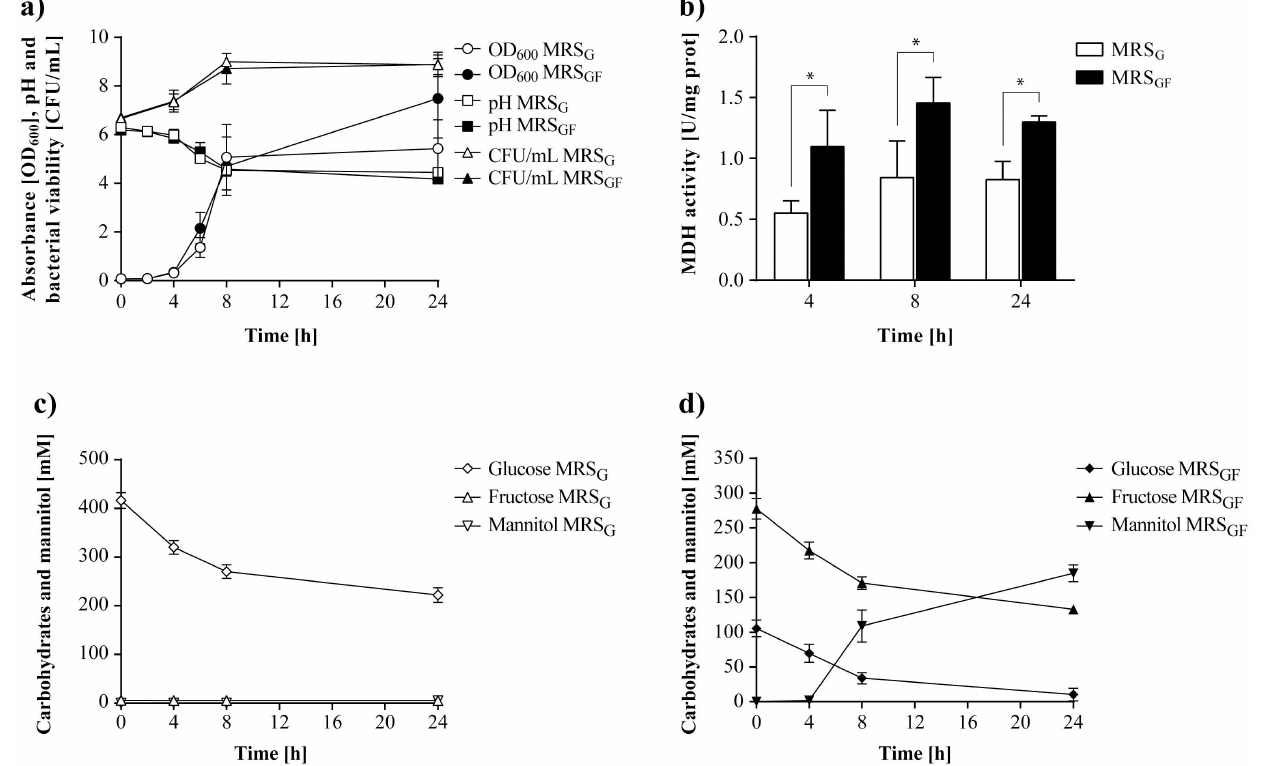
Fig 2. Cell growth and MDH activity of L . reuteri CRL 1101 grown in MRS G and MRS GF at 37˚C for 24 h. a) Growth kinetics in both media; b) Specific MDH activity in both media; c, d) Carbohydrate consumption and mannitol production in MRS G and MRS GF , respectively. Statistical analysisin Fig 2b was performed using two-way ANOVA followedby Bonferroni post-test. A value of p < 0.05was consideredstatistically